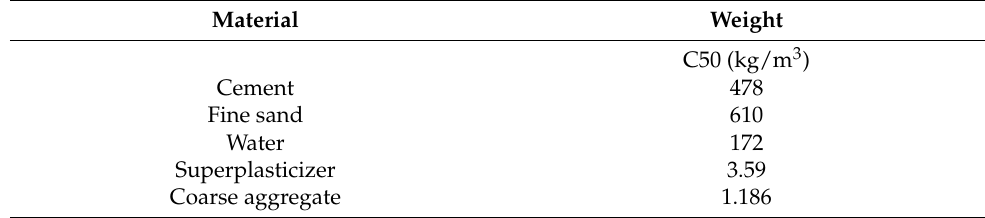
Table 1. Composition of C50.